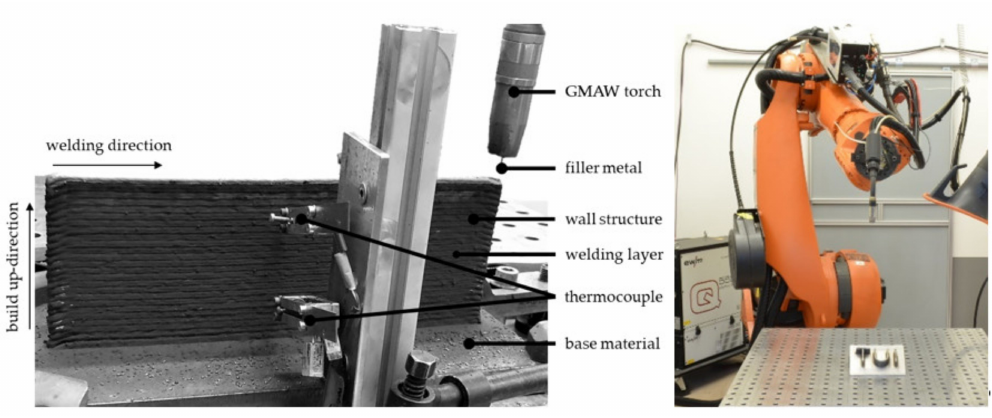
Figure 2. Experimental setup. Table 2. Parameter sets for additive